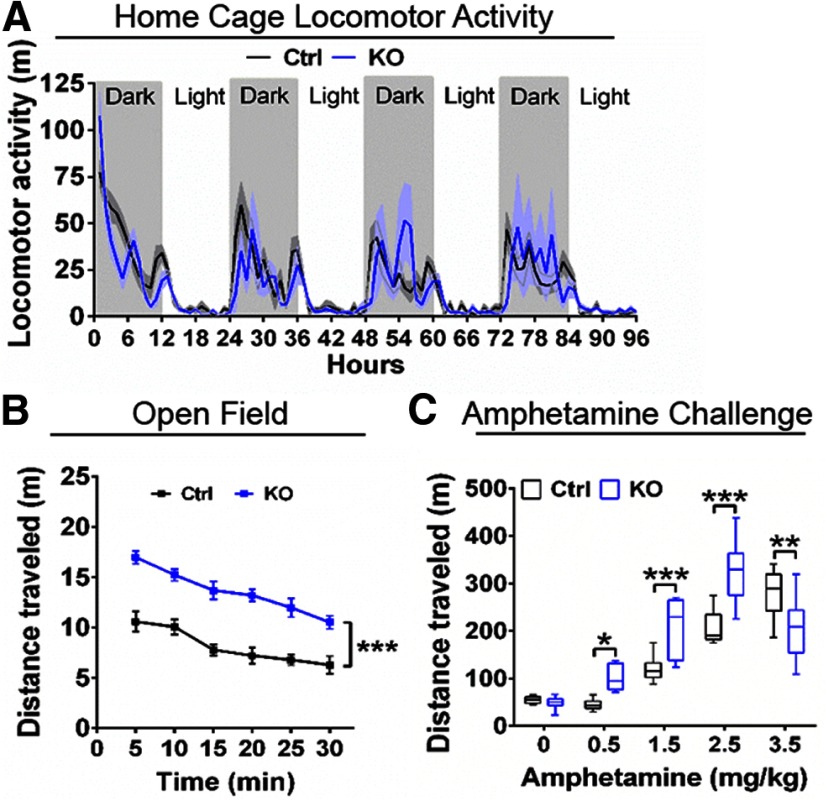
ErbB4 KO mice are hyperactive in novel environments and sensitive to systemic amphetamine. A, Horizontal locomotor activity of control (Ctrl, black) and ErbB4 KO (KO, blue) mice scored in their home cages for 96 h (n = 8/genotype, p > 0.05). B, Locomotor activity of ErbB4 KO mice (KO, blue) is significantly elevated relative to controls (Ctrl, black) in the novelty open field test (n = 9/genotype, F(2,24) = 36.77, p < 0.0001). C, Locomotor activity of controls (Ctrl, black) and ErbB4 KO mice (KO, blue) following administration (intraperitoneal) of 0–3.5 mg/kg amphetamine. ErbB4 KO mice (0 mg/kg, n = 9; 0.5–3.5 mg/kg, n = 8) show locomotor hypersensitivity to systemic amphetamine administration at different doses as in contrast to Ctrl mice (0 mg/kg, n = 8; 0.5 mg/kg, n = 10; 1.5 and 2.5 mg/kg, n = 8; 3.5 mg/kg, n = 9; F(1,74) = 16.85, p = 0.0001); *p < 0.05, **p < 0.01, ***p < 0.001.